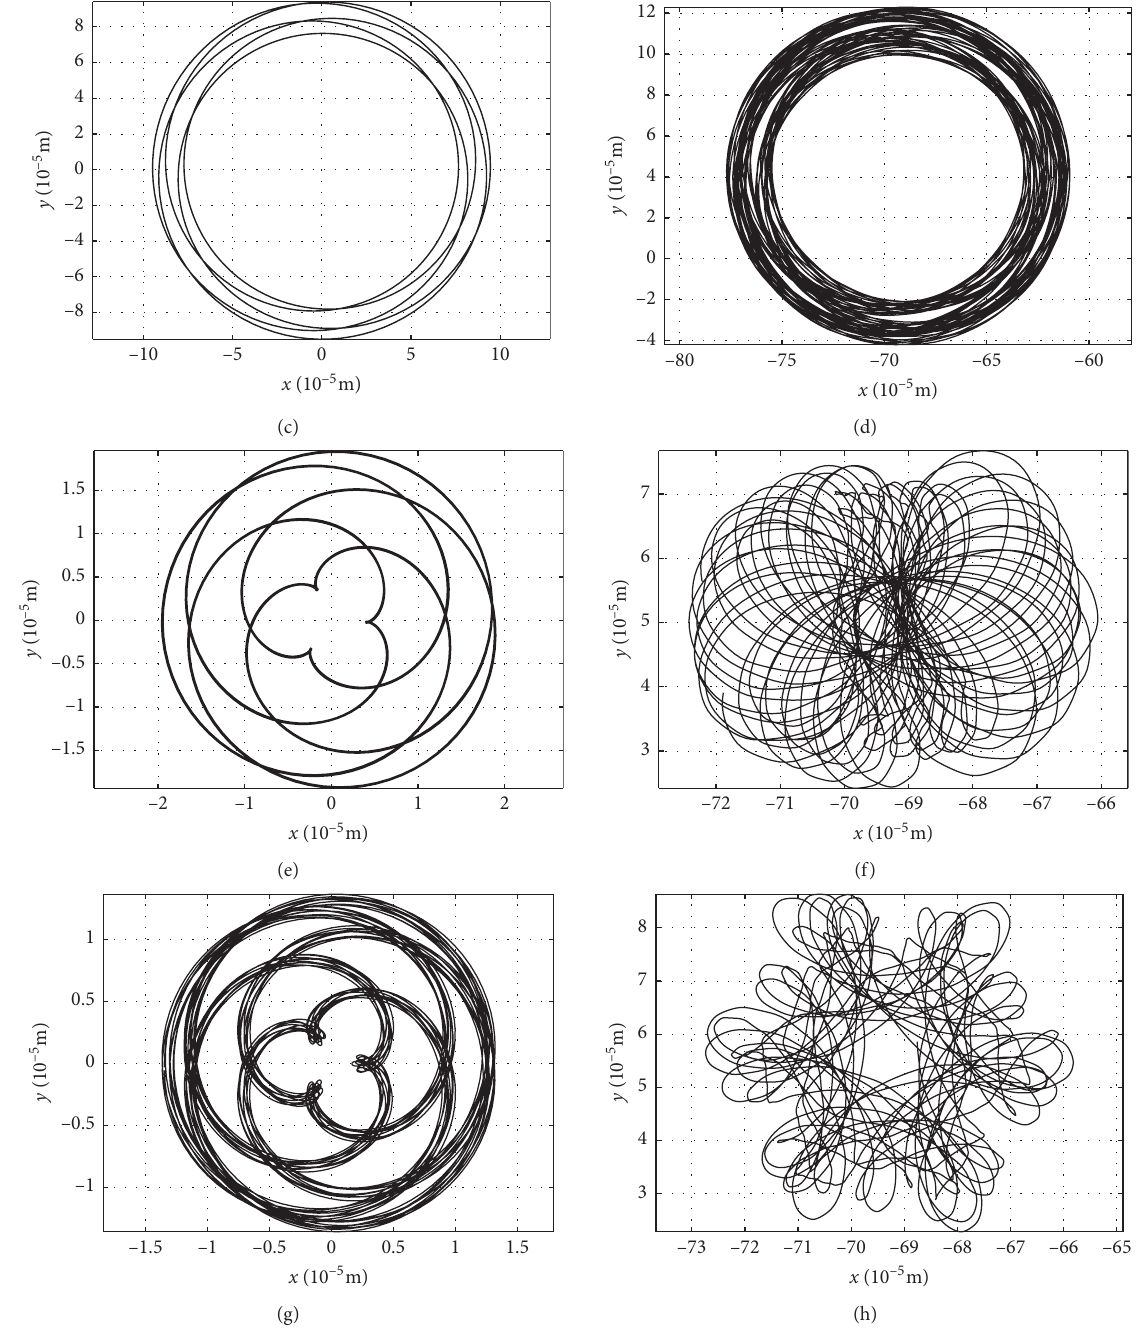
Figure 17: Orbit of disk 4. (a) 300rad/s, straight flight. (b) 300rad/s, hovering. (c) 400 rad/s, straight flight. (d) 400rad/s, hovering. (e) 500rad/s, straight flight. (f) 500rad/s, hovering. (g) 550 rad/s, straight flight. (h) 550rad/s,